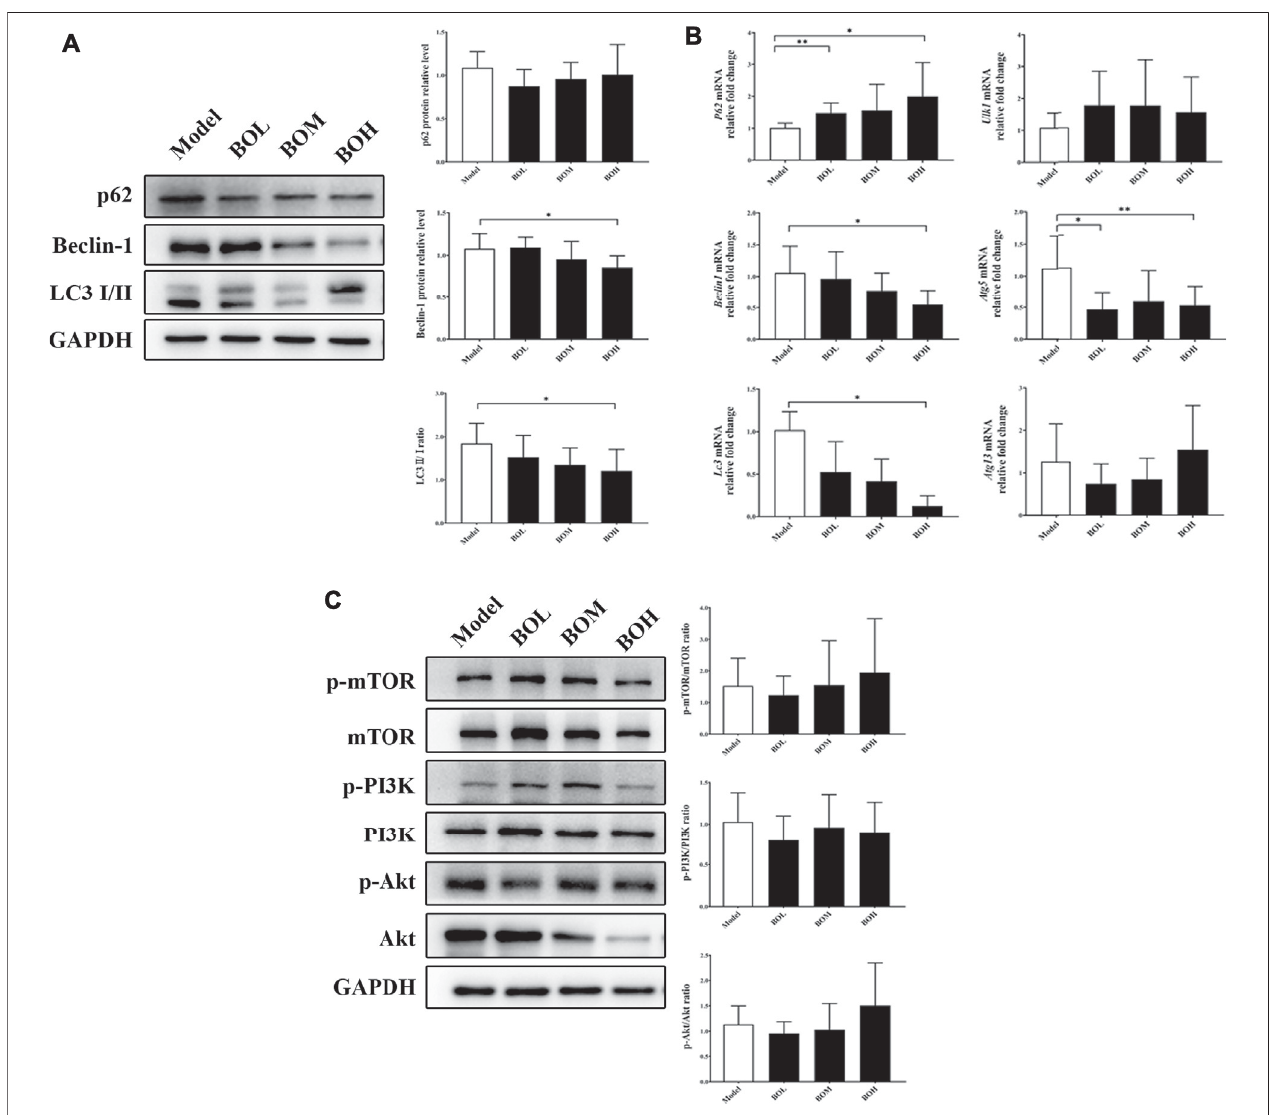
FIGURE 6 | BO restrains autophagy in MDA-MB-231 tumor without impact on PI3k/Akt/mTOR axis. (A) Protein expressions of autophagy-related proteins. (B) mRNA levels of autophagy-related genes. (C) Phosphorylations of mTOR, PI3K, and Akt. n (cid:2) 6. * p < 0.05 and ** p < 0.01 vs. model group.